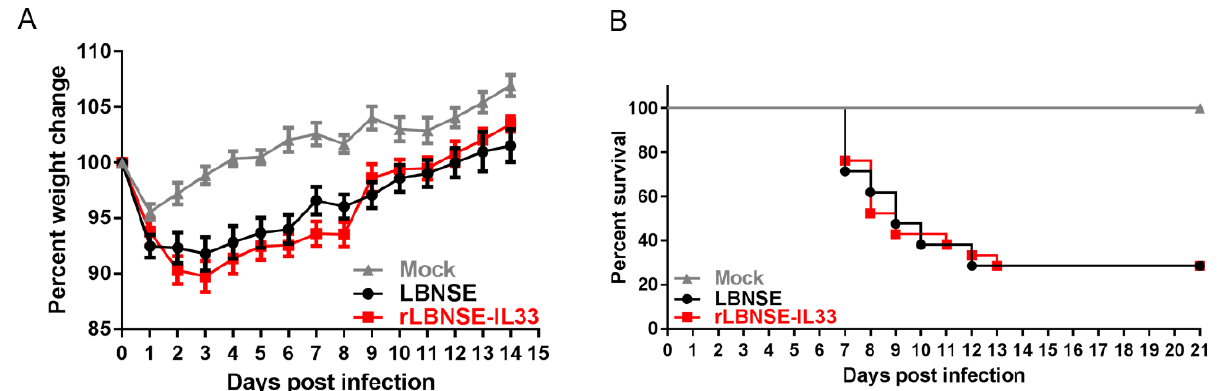
Figure 2. rRABVs pathogenicity in mice: ( A ) weight of six-week-old ICR female mice ( n = 10) i.c. infected with LBNSE (10 7 FFU), rLBNSE-IL-33 (10 7 FFU), or DMEM (as mock); ( B ) survival rates of five-day-old suckling ICR mice ( n = 21) i.c infected with LBNSE (100 FFU), rLBNSE-IL-33 (100 FFU) or DMEM (as mock). The error bars indicated standard error (SE).